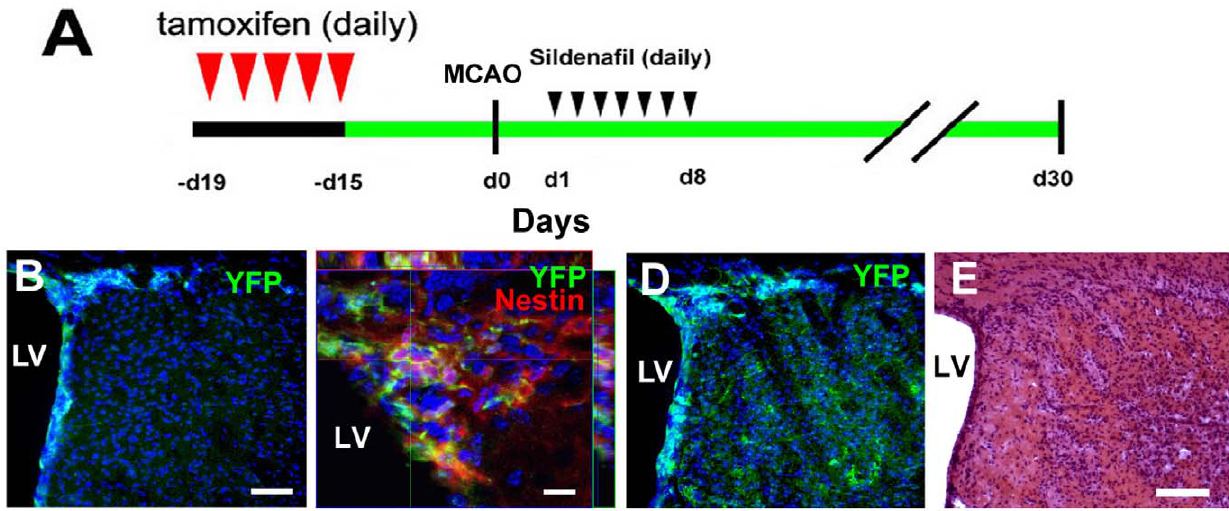
Figure 1. A diagram shows experimental protocols (A). Confocal microscopic images show YFP positive cells in non-ischemic brain 14 days after injection of tamoxifen (B and C) and YFP positive cells in ischemic striatum 30 days after middle cerebral artery occlusion (MCAO, D). An orthogonal view shows that several YFP immunoreactive cells (green) were nestin positive (red) in the anterior SVZ of the lateral ventricle of non- ischemic brain (C). A light microscopic image of hematoxylin and eosin (H&E) stained coronal section shows striatal ischemic lesion 30 days after MCAO (E). Bars=100 m m for B, and D, 10 m m in C, and 100 m m in E. Blue color = cell nuclei. LV = lateral ventricle. D0 represents the day of MCAO.